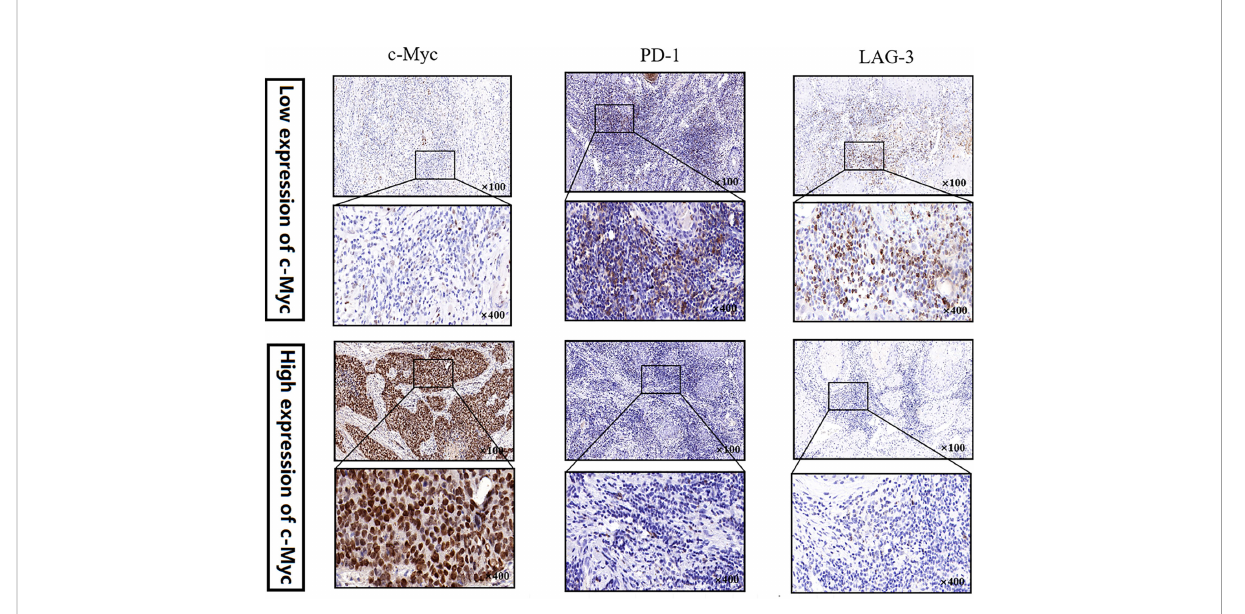
FIGURE 8 c-Myc, PDCD1 and LAG3 expression in an OSCC TMA by